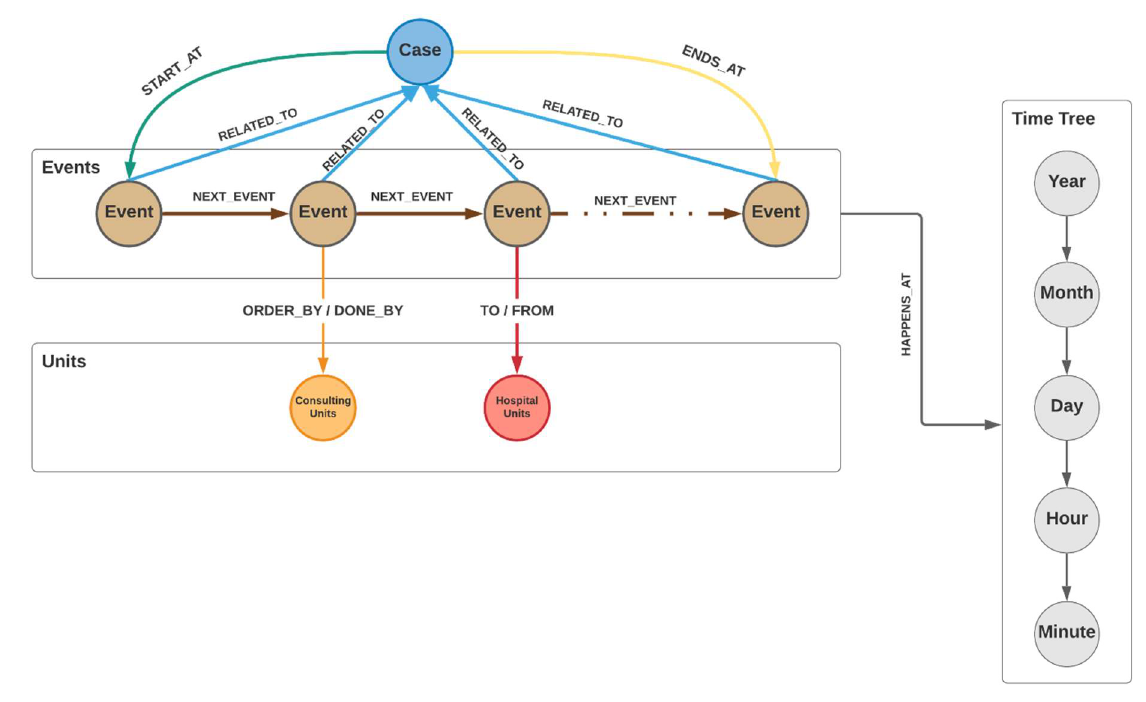
Figure 1. TVG model for patient flow network schema.